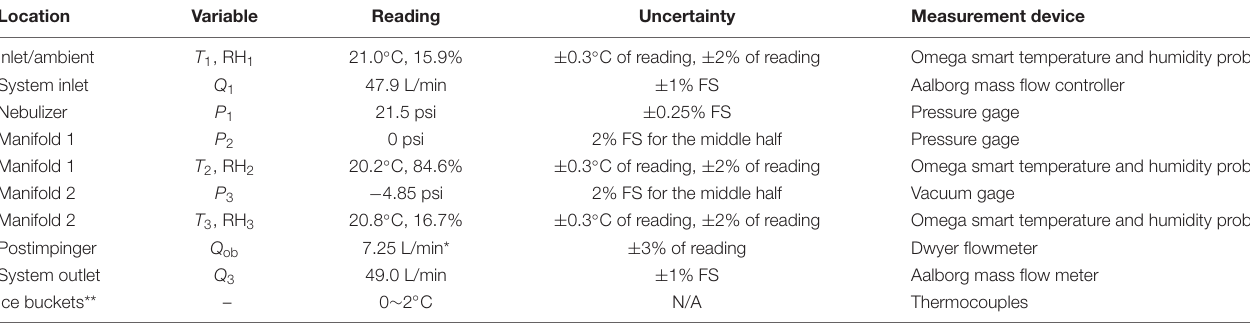
TABLE 3 | Sample data collection for all variables needed for mass balance and uncertainty